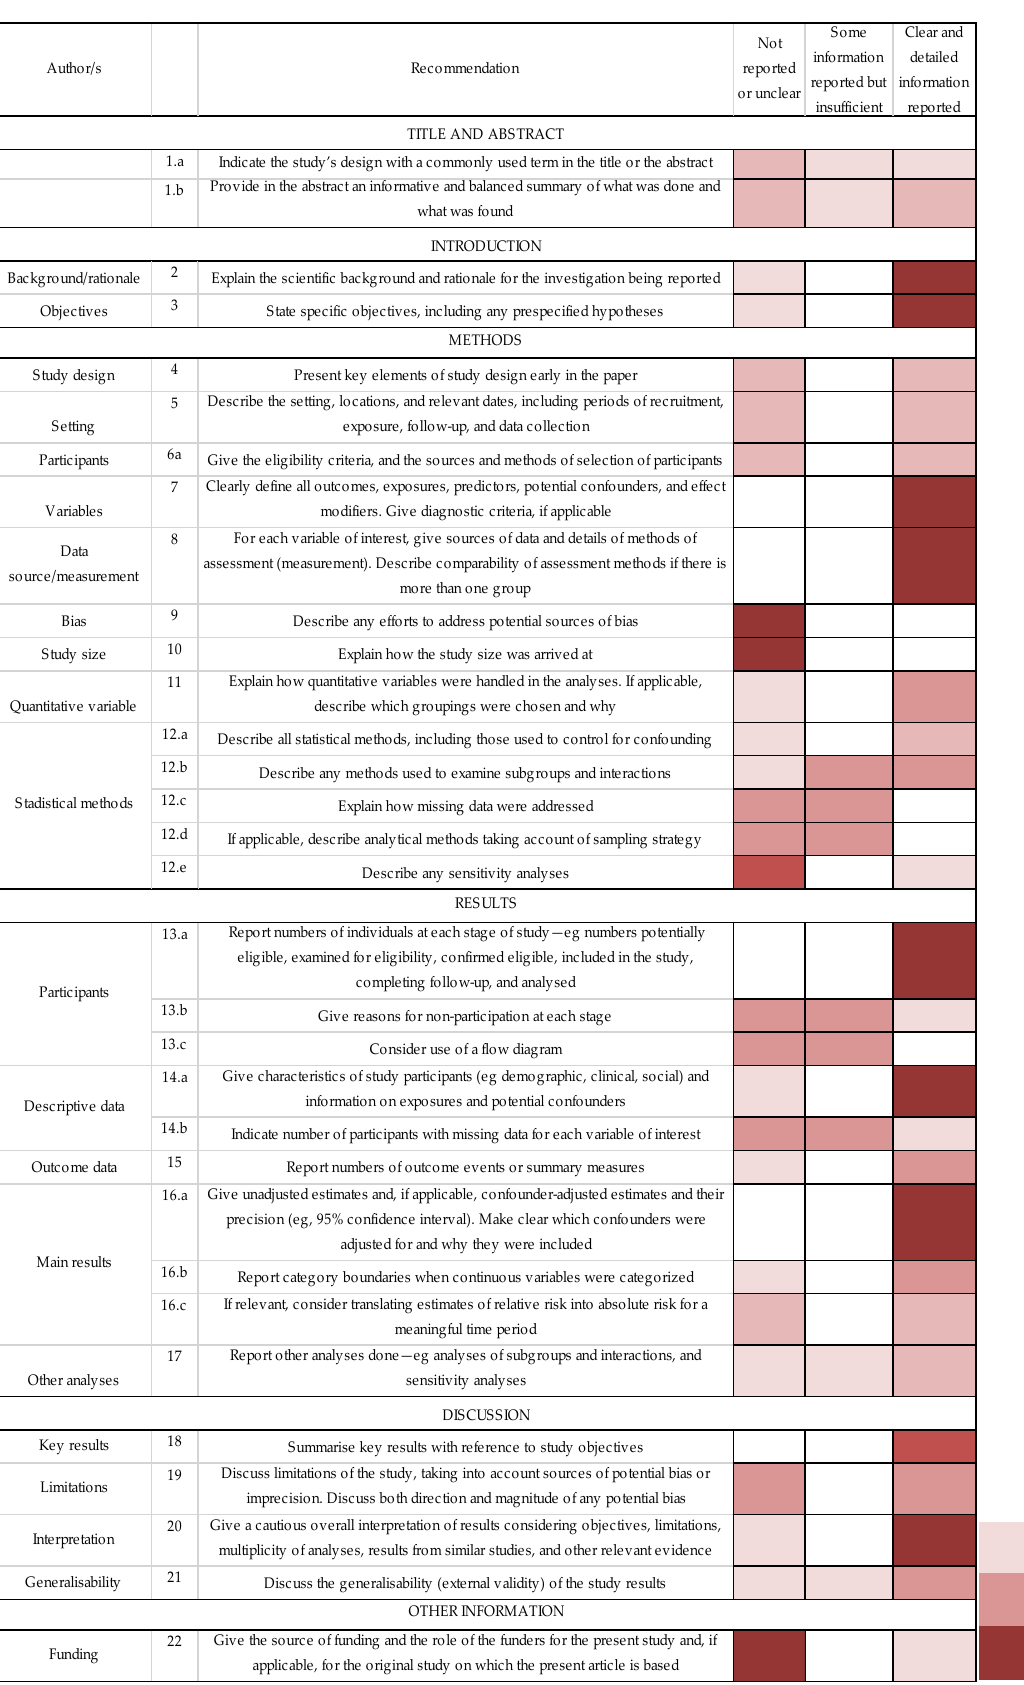
Figure 2. Assessment of reporting completeness and quality of included studies (STROBE).